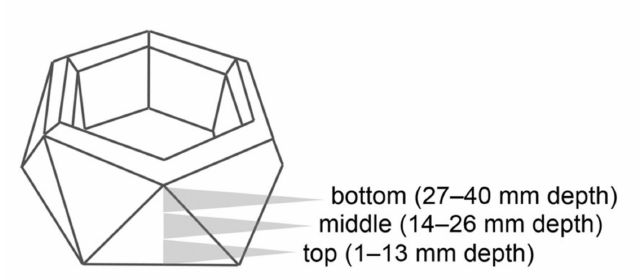
Figure 3. Sectioning of test specimens for swelling